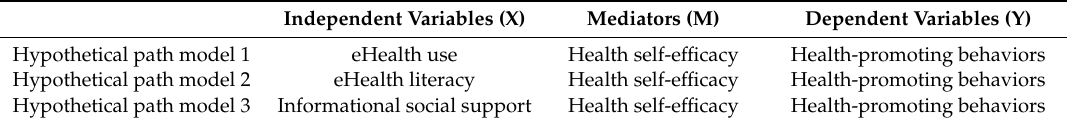
Table 2. Variables of regression equations in path